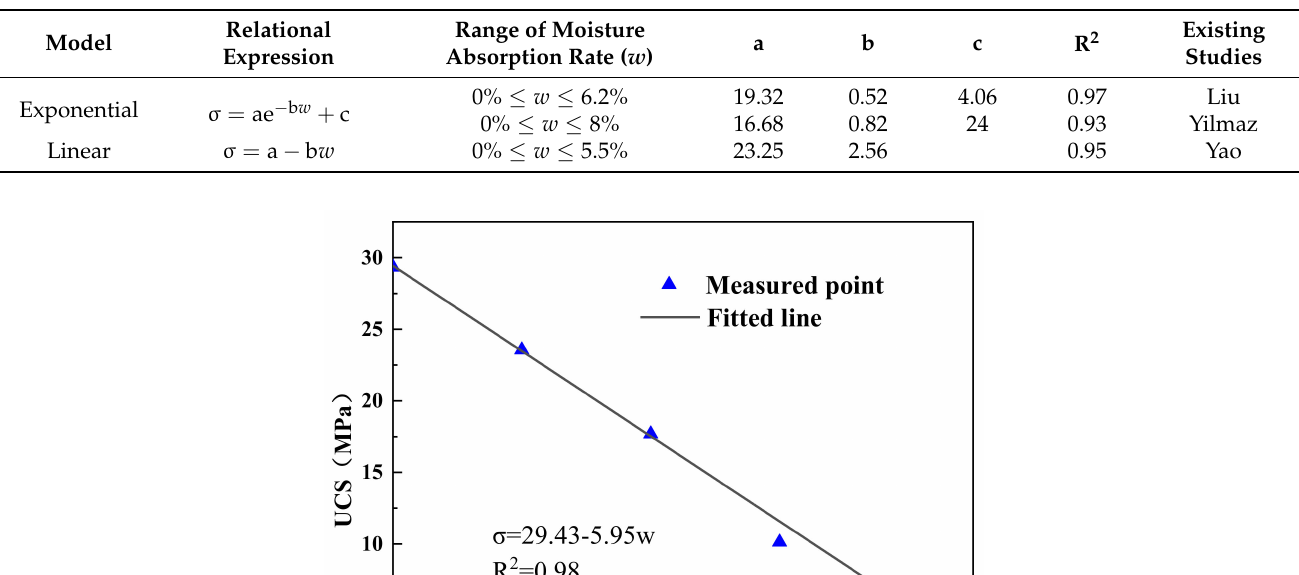
Table 4. Model of the relationship between UCS and moisture absorption in existing studies.